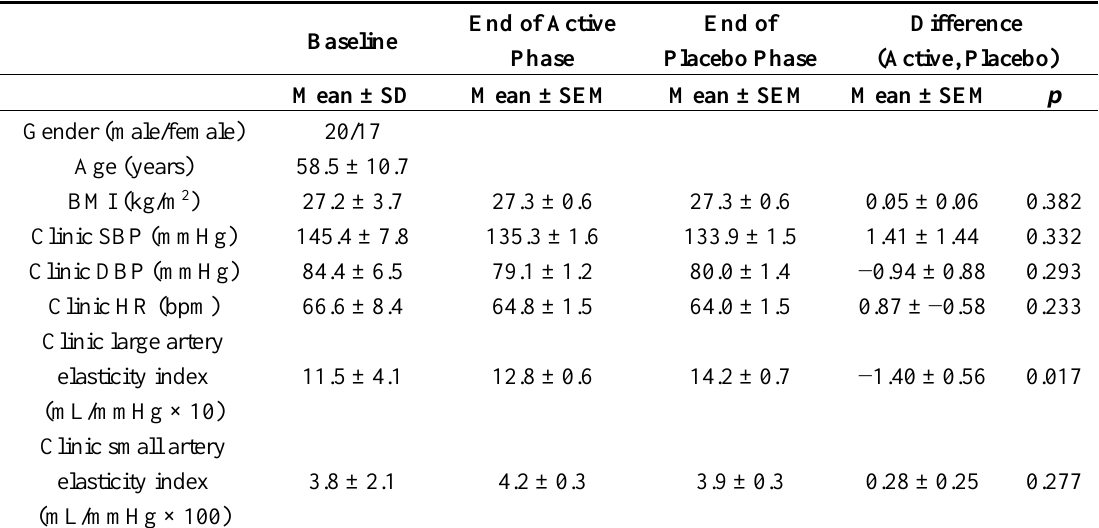
Table 1. Participant characteristics, clinic BP (blood pressure), HR (heart rate) and AC (arterial compliance) at baseline (Week 0) and at the end of the active phase and placebo phase ( n = 37). SBP, systolic BP; DBP, diastolic BP.